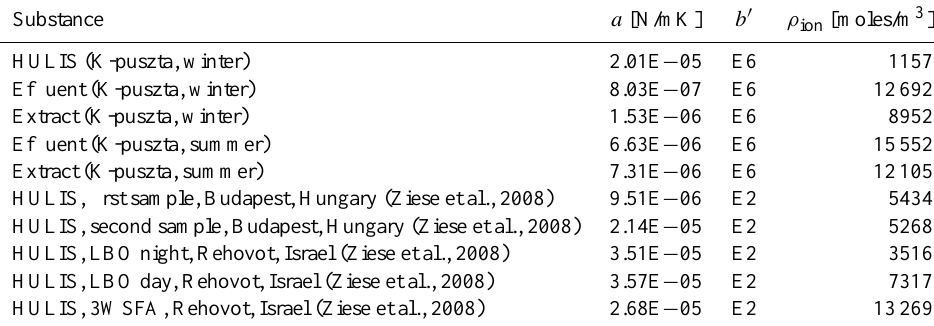
Table 6. Fitted parameters for the ρ ion model for K-puszta compared to previous calculations from Ziese et al. (2008). Note that ρ ion is given using the fitted surface tensions while in Table 3 the corresponding numbers for the κ R model are listed using the surface tension of pure